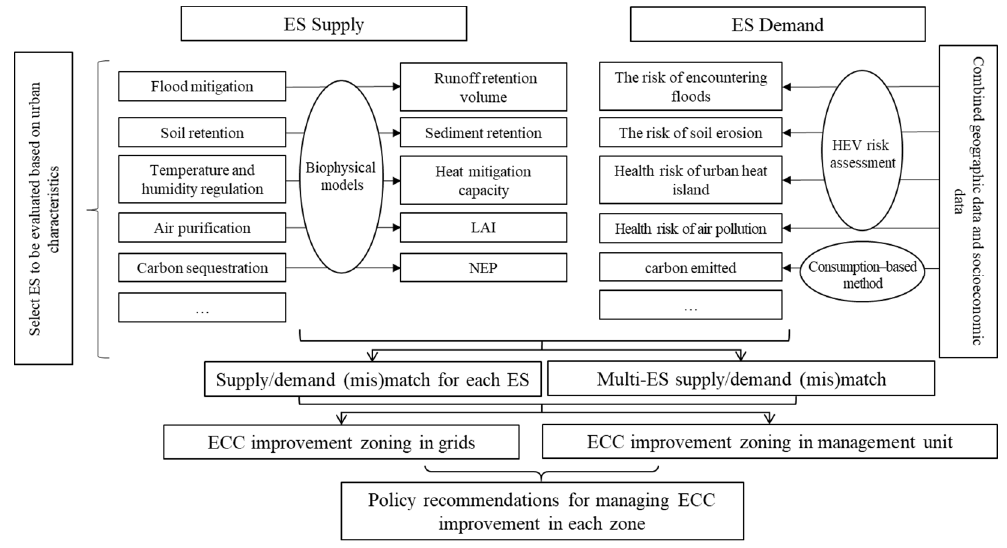
Figure 1. The technical route of this study.